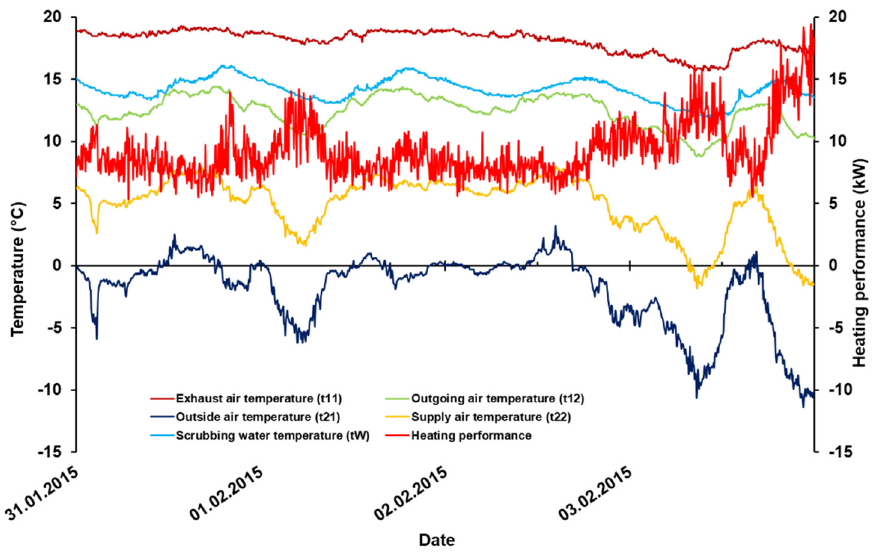
Figure 4. Heating performance and temperature profiles at the measuring points of the exchange scrubber pilot plant under field conditions during the measurement period with assembly situation A of the heat exchanger (31 January 2015–3 February